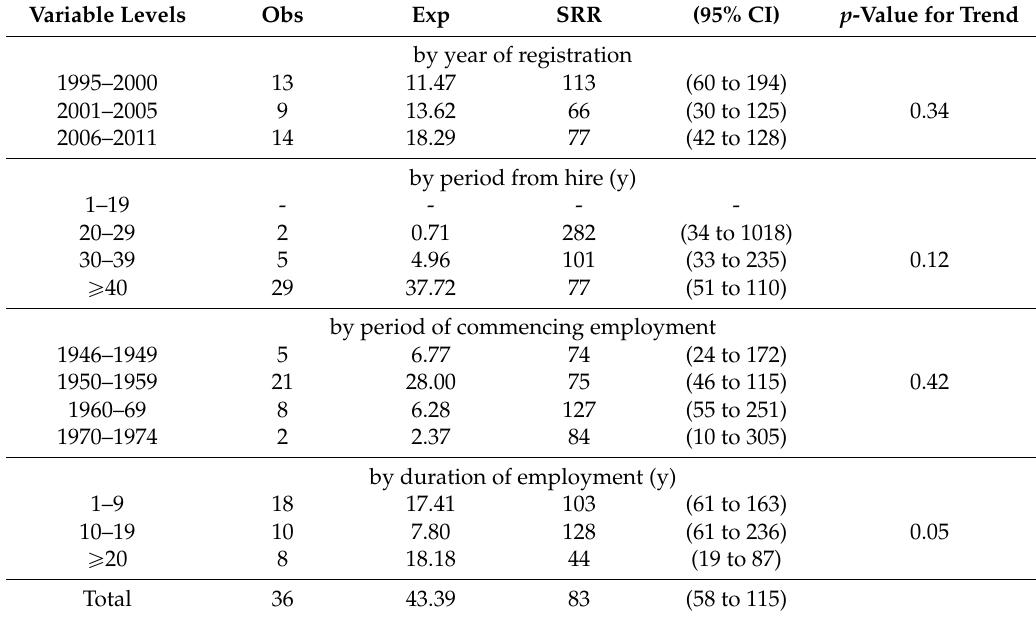
Table 4. Incidence of myelodysplastic syndrome (MDS) (ICD-10:D46) in 28,554 UK oil refinery